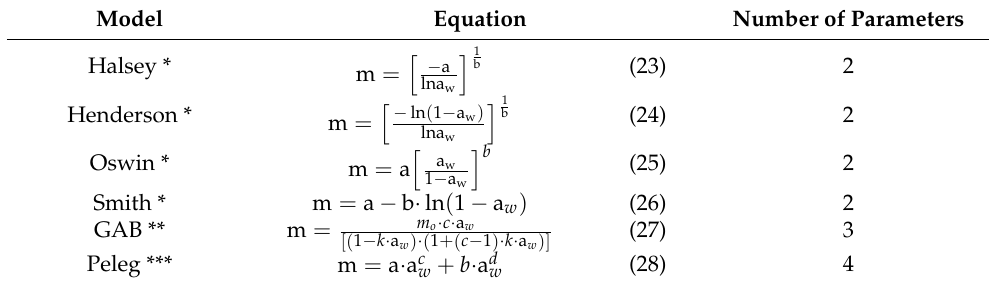
Table 6. Mathematical models used to describe the moisture sorption isotherms of purple basil leaves. Model Equation Number of Parameters Halsey